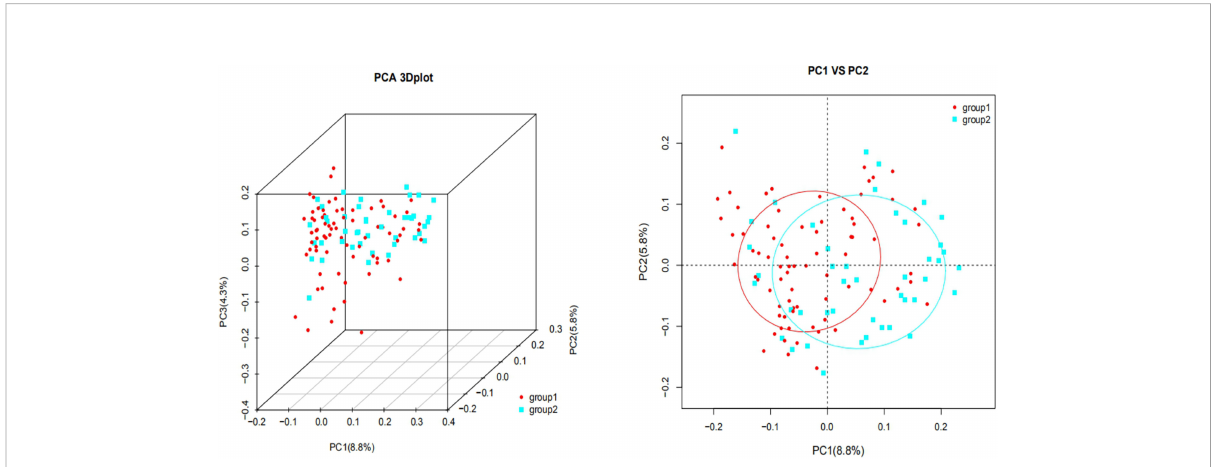
FIGURE 2 UniFrac ranking diagram based on principal coordinate analysis [2A (Left): three-dimensional, 2B (Right): two-dimensional. group 1: plateau group; group 2: plain group) The similarity and dissimilarity of bacterial community structures between the two groups were evaluated by PCoA that based on Bray-Curtis distances at the OTU level at 97% identity. The distribution of the two groups overlapped partially. PC1 explained 8.8% of the variation observed, and PC2 explained 5.8% of the variation.